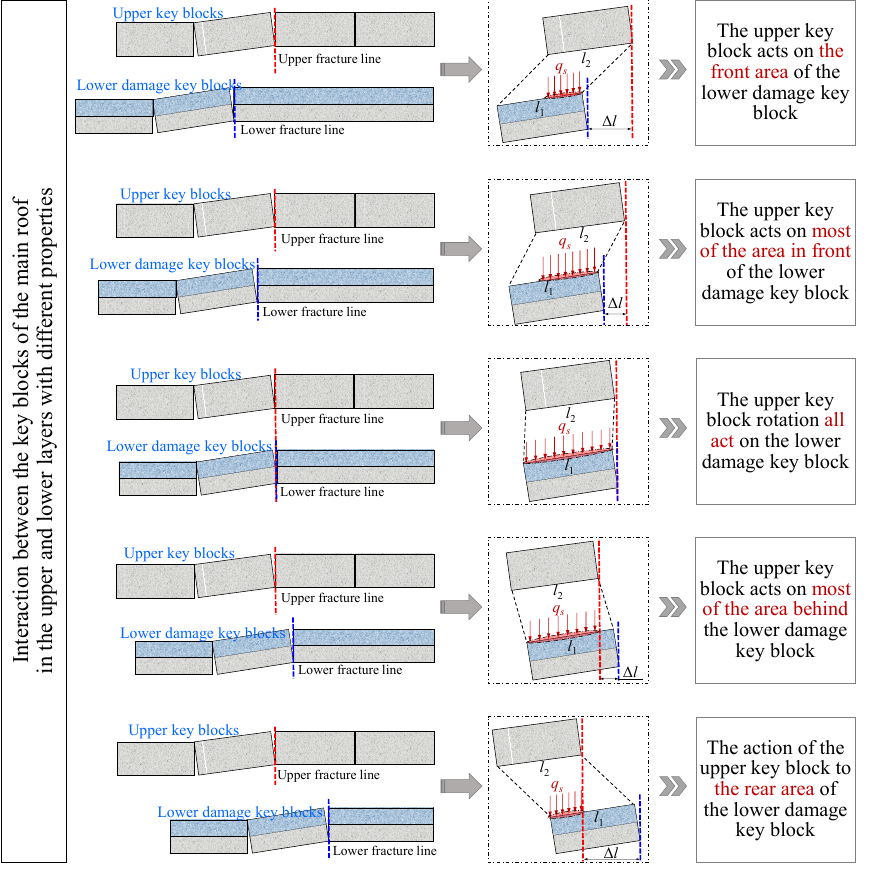
Figure 12. Interaction of the upper and lower main roofs with different properties.